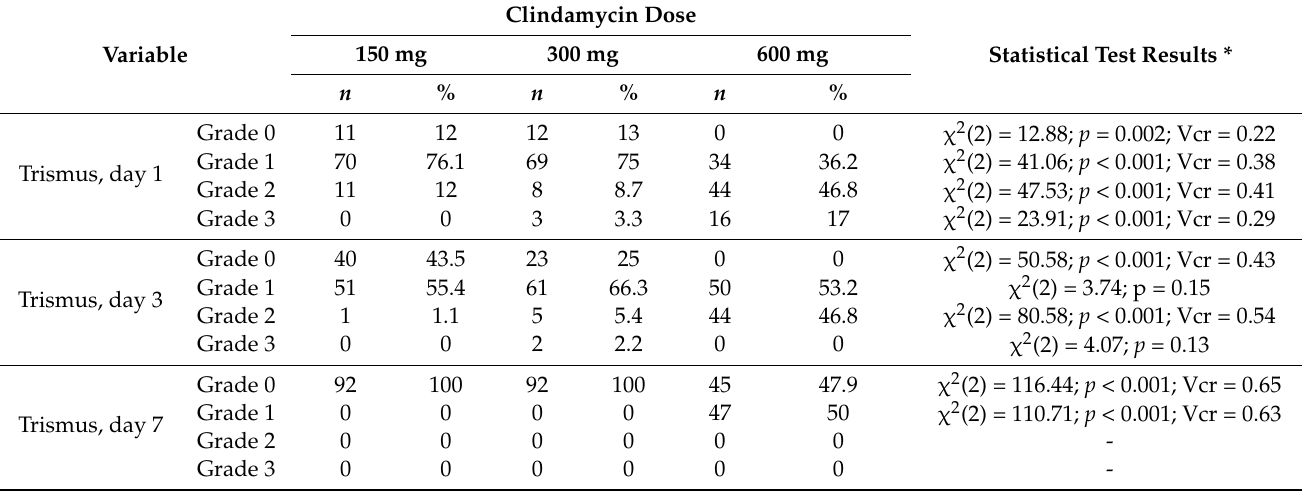
Table 2. Trismus in the study